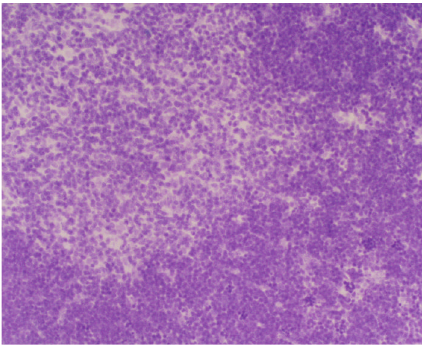
Figure 6: Treated group: 12 hours; Tunel × 200.